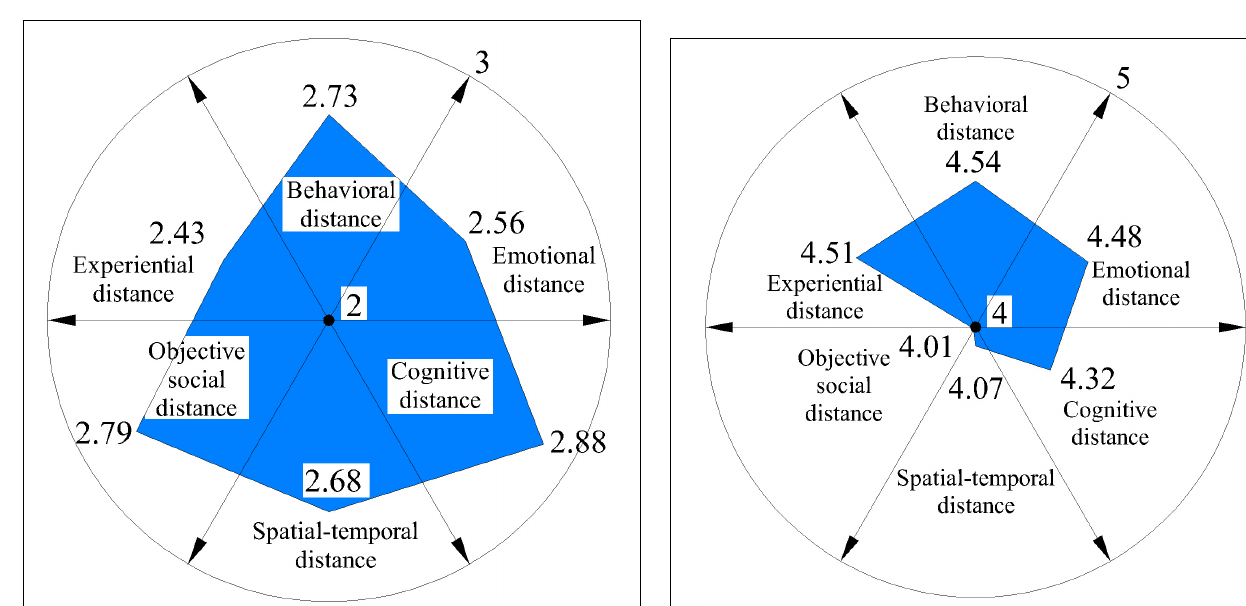
FIGURE 4 | Average psychological distance distribution on loyalty relationship.